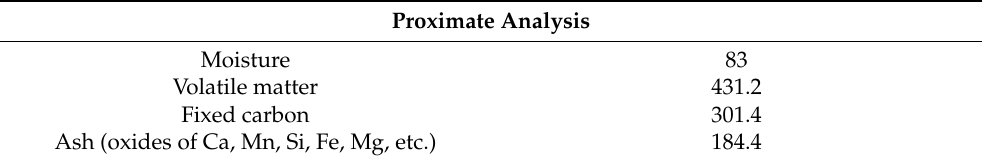
Table 6. Major components of rice bran (mg/g) (modified from [87]).